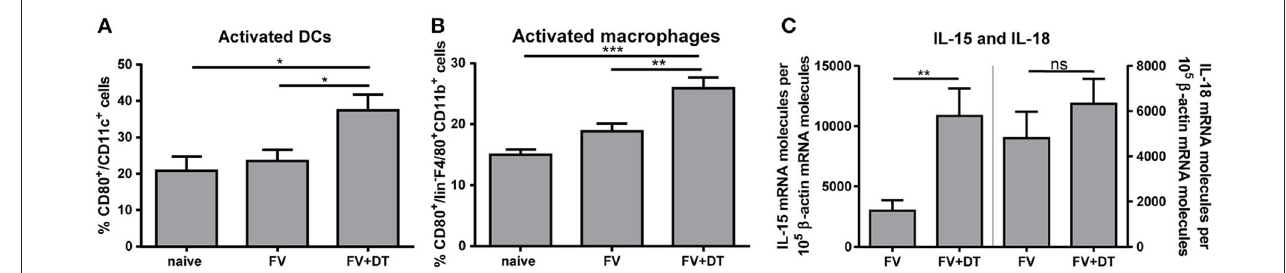
FIGURE 2 | IL-15 and IL-18 mRNA expression levels and activation of DCs and macrophages in FV-infected mice. DEREG mice were infected with FV and depleted for Tregs by repeated injections of DT. Mice were sacrificed at 3 dpi and uninfected mice were used as controls. Spleen cells were analyzed for the activation of CD11c + DCs ( A ; naïve n = 10, FV n = 15, FV + DT n = 12) and F4/80 + CD11b + macrophages ( B ; naïve n = 10, FV n = 15, FV + DT n = 12) by detection of the surface molecule CD80. At least 10 animals per group from at least 3 independent experiments were used for the Ordinary one-way ANOVA. mRNA expression levels of IL-15 (left; FV n = 16, FV + DT n = 14) and IL-18 (right; FV n = 16, FV + DT n = 14) were analyzed in splenocytes of FV-infected (FV) and Treg-depleted mice (FV + DT) by quantitative real-time PCR (C) . The housekeeping gene β -actin was amplified for each sample as an internal standard and for normalization. Samples were collected from at least three independent experiments and were run in duplicate. Outliers were removed using the Rout method. Statistically significant differences were analyzed by Mann-Whitney test and are indicated by * p < 0.05, ** p < 0.01, *** p < 0.001. Mean values are displayed, with SEM indicated by error